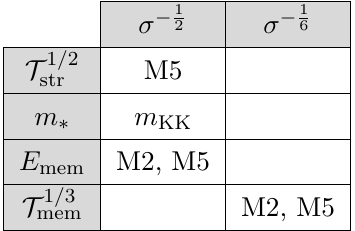
Table 11 . Mass scalings along the flow generated by an elementary string obtained from an M5 wrapped over the four-cycle ˜ C a .